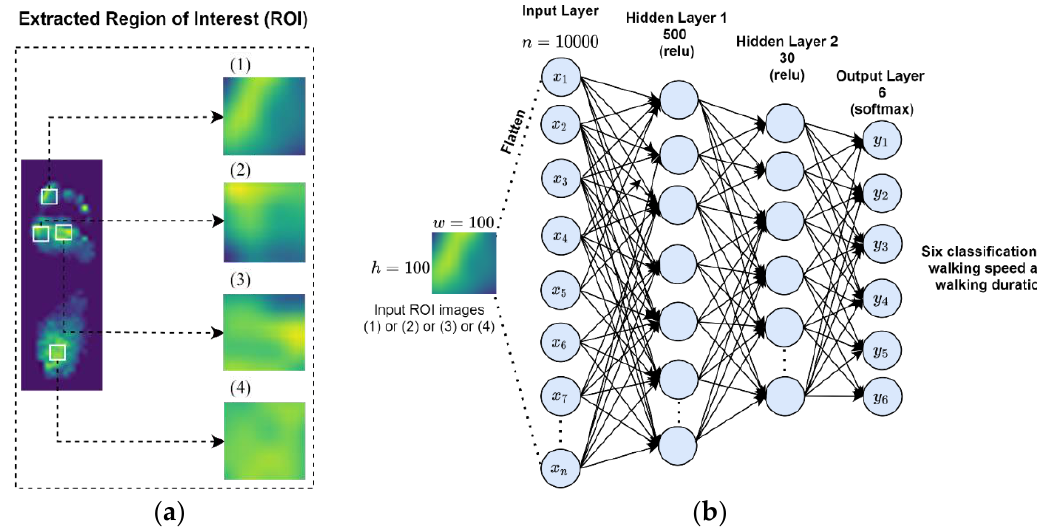
Figure 2. Region of Interest (ROI) input images and ANN model architecture. ( a ) ROI images: the input contributes to the classification model. The extracted ROI consists of four plantar pressure regions defined as: (1) T1, (2) M1, (3) M2, and (4) HL; ( b ) the ANN model architecture is utilized for classifying walking speeds and walking durations. T1, first toe; M1, first metatarsal head; M2, second metatarsal head; HL, heel.